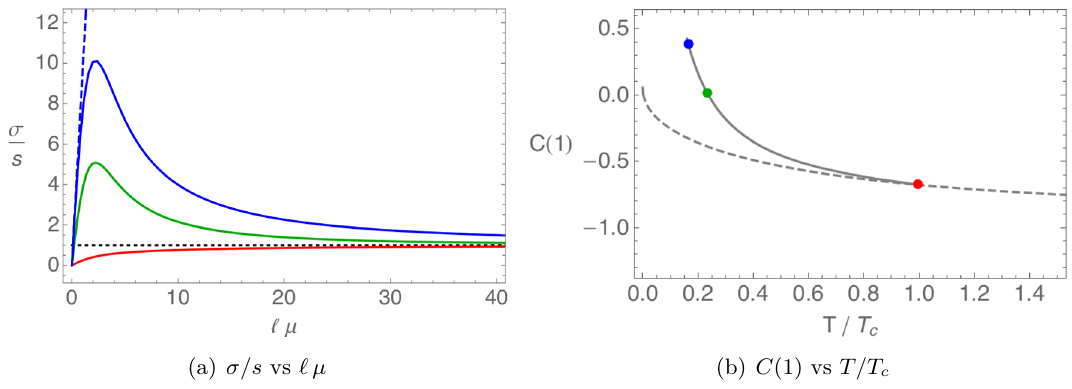
Figure 4 . Entanglement density of the superconducting phase at M 2 = 0 . (For M 2 > 0 we obtained qualitatively the same plots.) Left: σ/s (solid lines) at T/T c = (1 , 0 . 23 , 0 . 16) (red, green, blue). The black dotted line is the guide line for σ/s = 1 and the blue dashed line is (2.20). Right: C (1) for the superconducting phase (solid line), the normal phase (dashed line). Dots correspond to data used in figure 4(a).